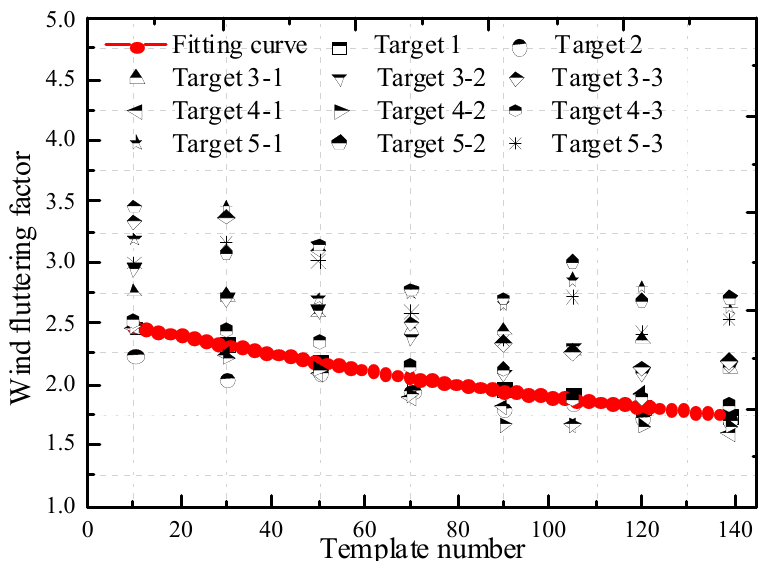
Figure 11. Fitted curve of wind vibration coefficients under the five equivalent targets for eight working conditions. Table 6. Recommended values of wind vibration coefficient under each working condition.